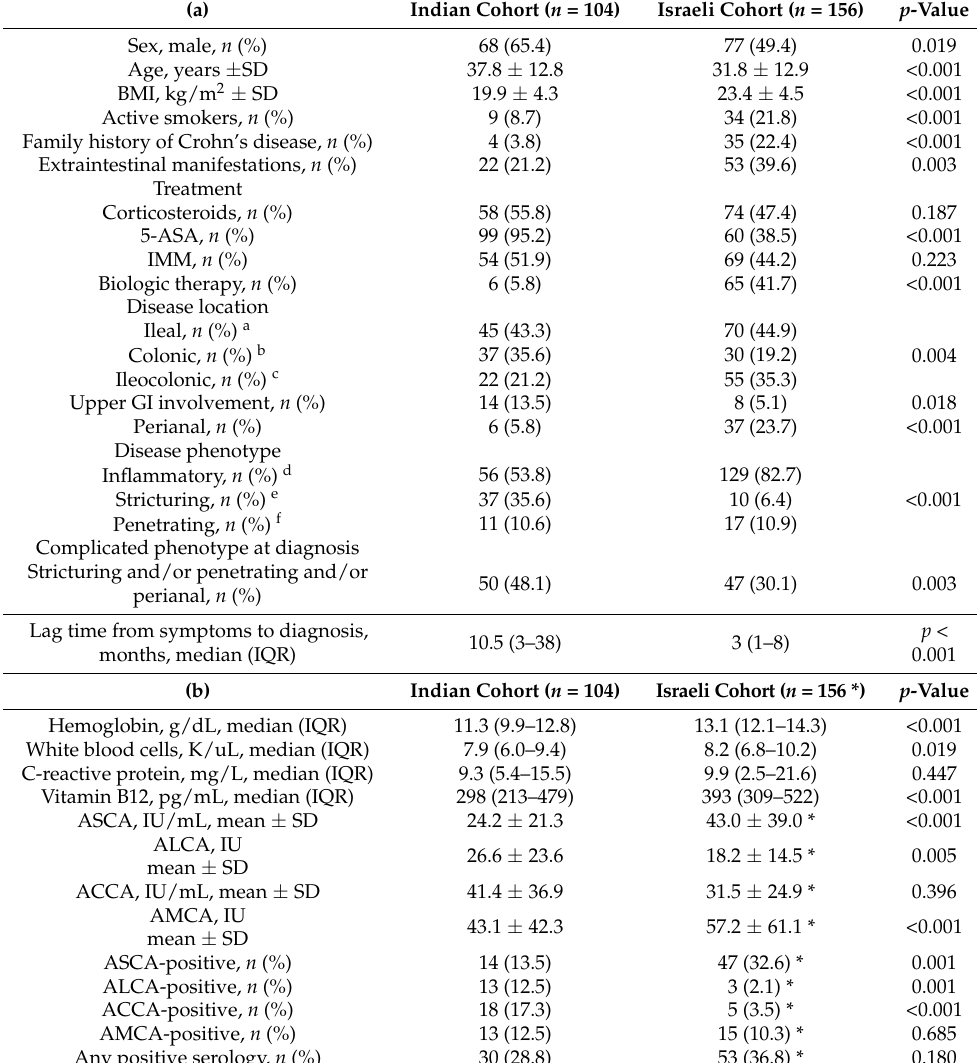
Table 1. (a) Demographic and clinical characteristics of Indian and Israeli cohorts ( n = 260). (b) Biochemical characteristics and antiglycan serologic responses magnitude and seropositivity rates at the presentation of the Indian and Israeli cohorts ( n =